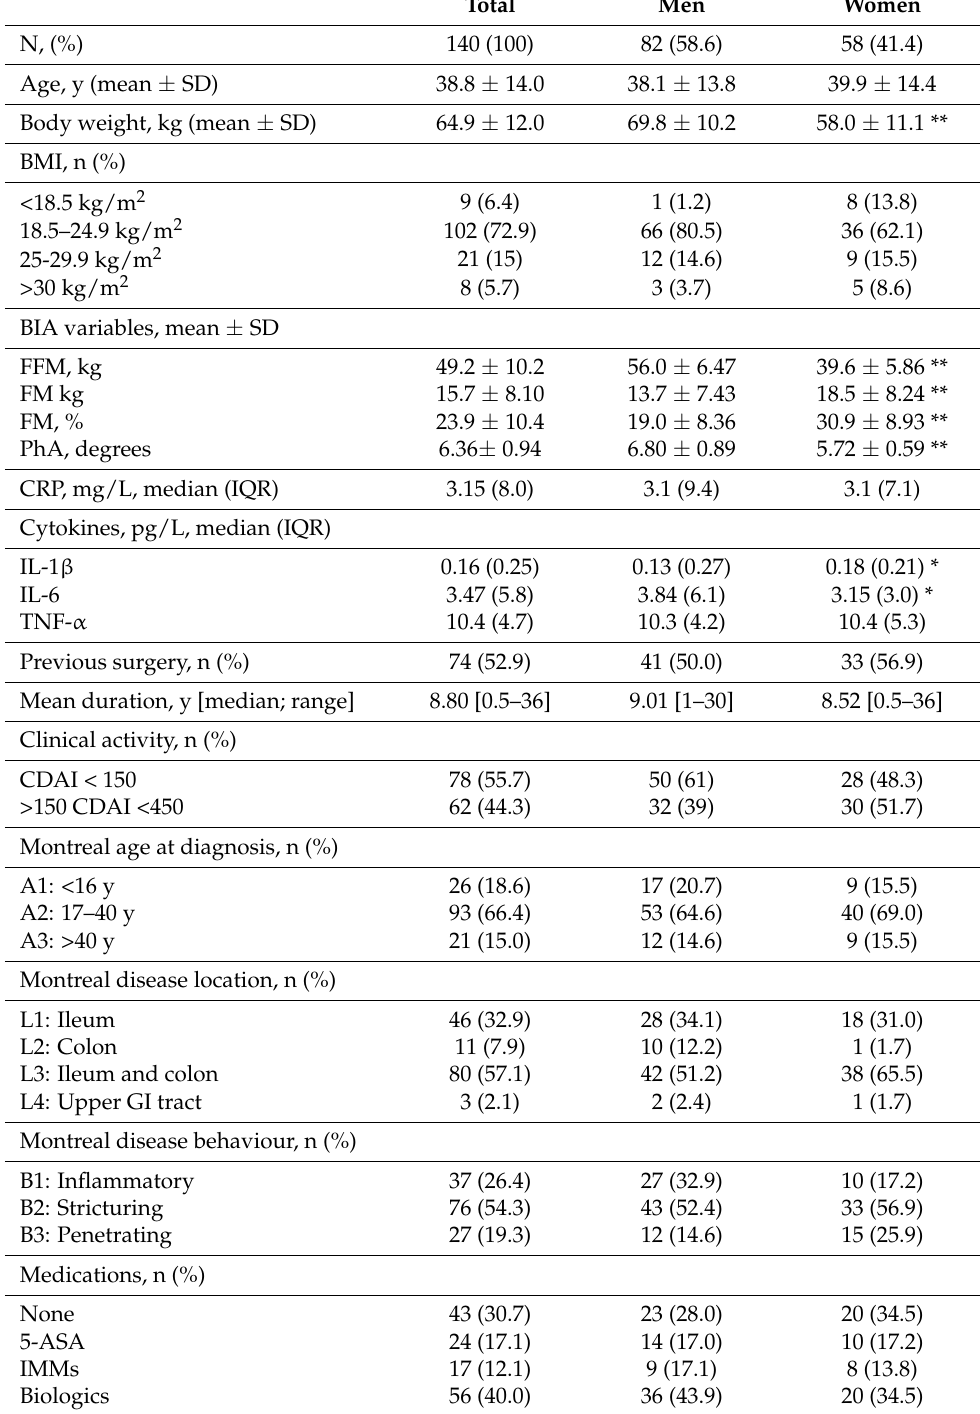
Table 1. Demographic and clinical characteristics of CD